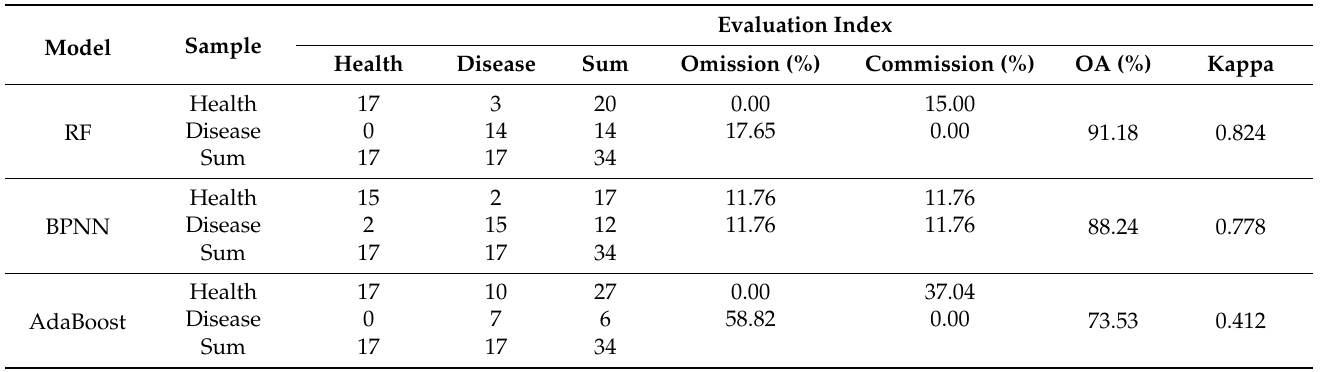
Table 5. Verification results of the three monitoring models based on highly correlated and significant different feature variables.